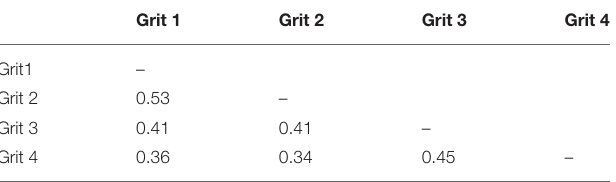
TABLE 2 | Correlation matrix between grits over time.